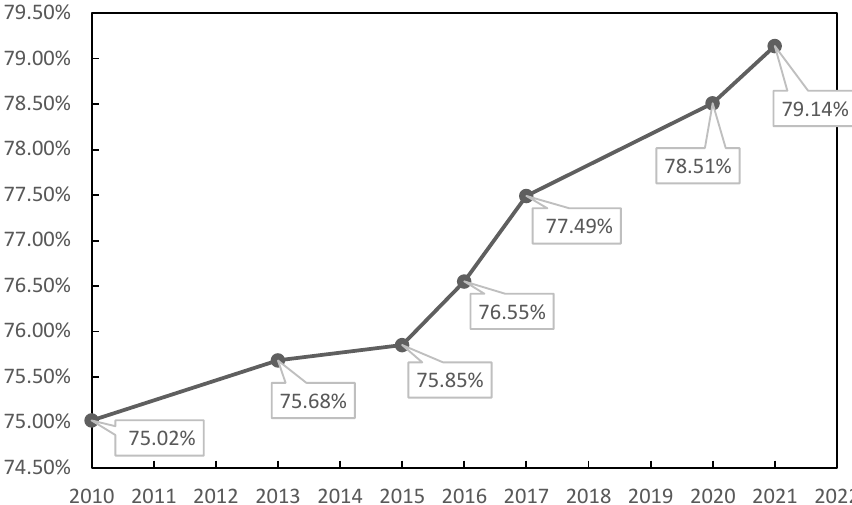
Figure 7. Line chart of vegetation coverage change in CIVE model.